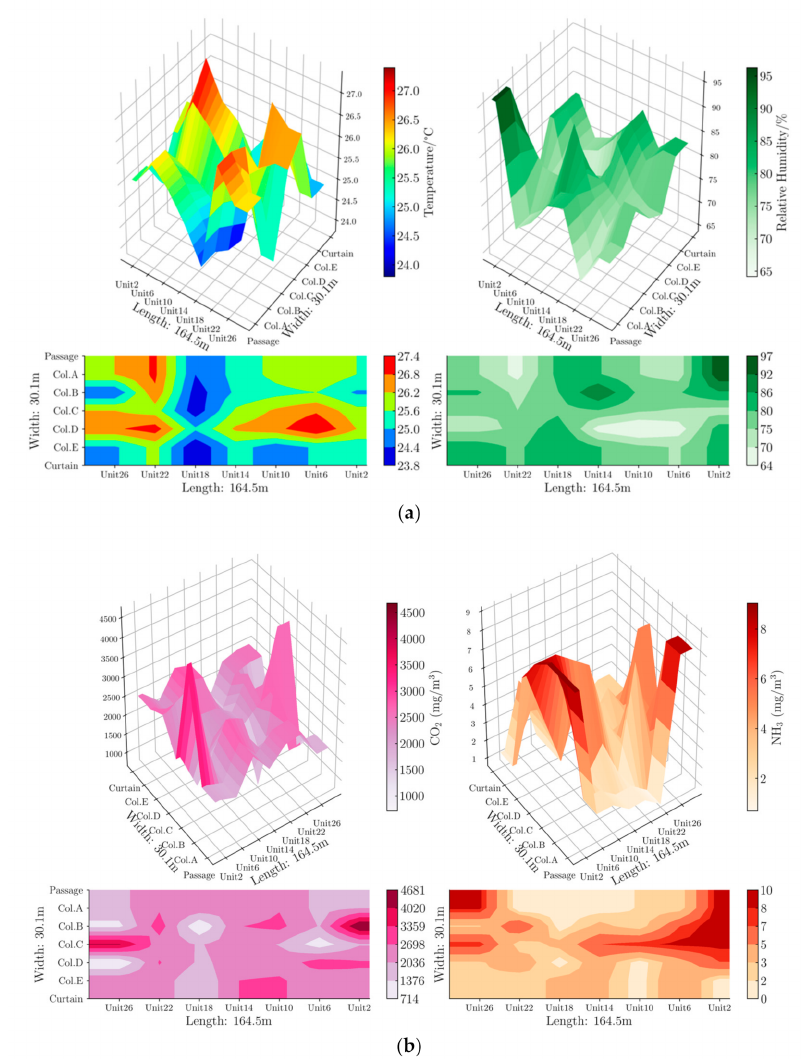
Figure 14. ( a , b ) The three-dimensional surface plots and corresponding contour plots of sow’s respiratory zone and upper region above sow’s head recorded on 15:04 13